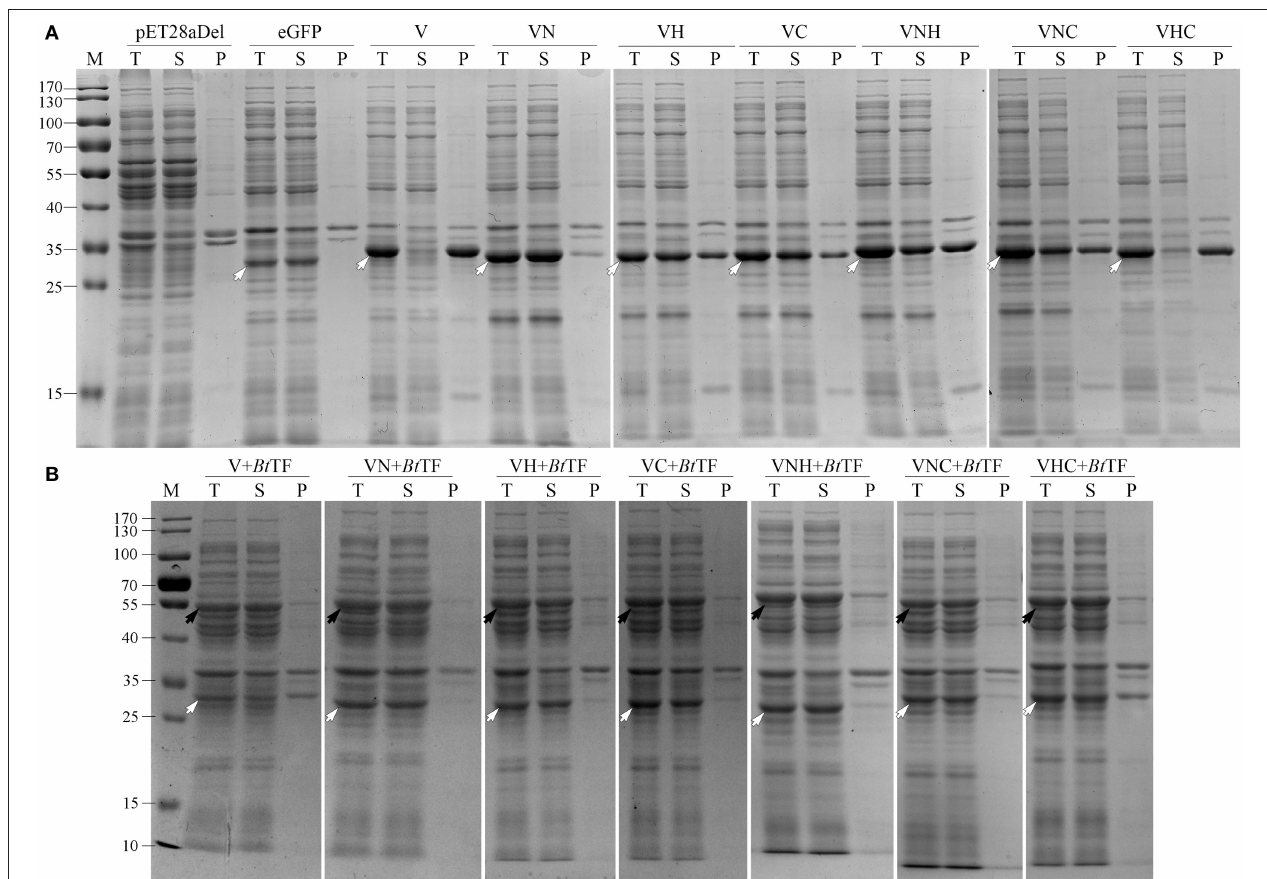
FIGURE 7 | The solubility analysis of the fusion fluorescent proteins with (A) or without (B) the coexpression of Bt TF. For each sample, the total proteins (T), the soluble component after cell lysis (S), and the precipitates (P) were loaded. The black arrows indicate the target bands of Bt TF and the hollowed arrows indicate the target recombinant proteins including eGFP, VeGFP (V), VNeGFP (VN), VHeGFP (VH), VCeGFP (VC), VNHeGFP (VNH), VNCeGFP (VNC), and VHCeGFP (VHC). Lane “M” is the molecular weight